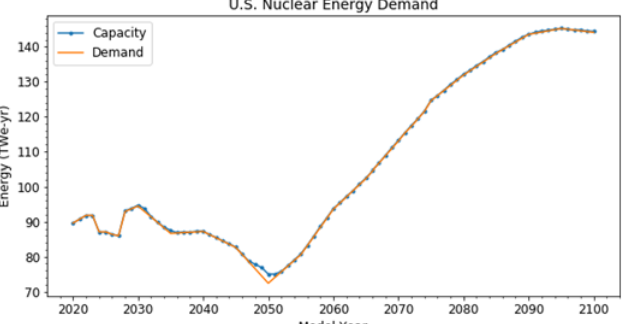
Fig. 2. Base scenario U.S. nuclear energy demand and total generating capacity.